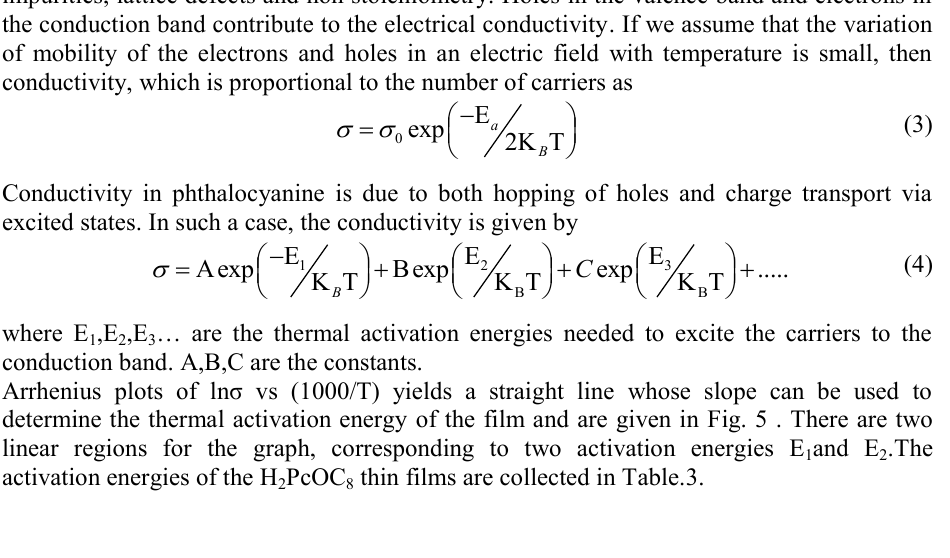
Table 2. Grain size of the H